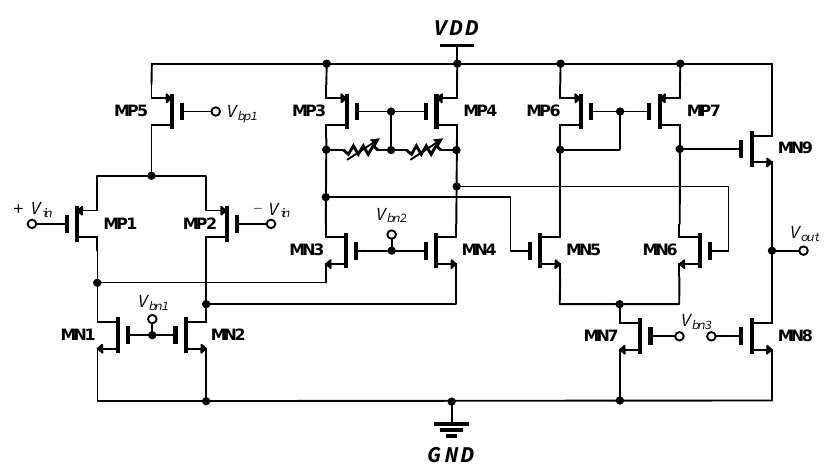
Figure 4. Schematic of the three-stage folded cascode amplifier.